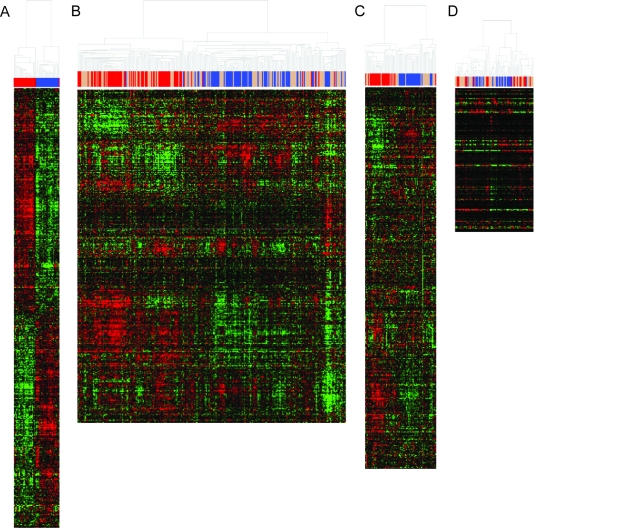
Heatmap of core serum response genes in each of the four data sets considered. Red are serum induced samples, blue are serum independent samples, and tan are unclassified samples. (A) Expression of 484 Unigene mapped core serum response genes in the 50 in vitro samples of the primary experiment (Chang et al. 2004). (B) Expression of the 376 core serum response genes in the 295 prostate tumor samples (Glinsky et al. 2004) (C) Expression of the 421 core serum response genes in the 78 van’t Veer samples (van’t Veer et al. 2002) (D) Expression of the 158 core serum response genes in the 86 Beer samples (Beer et al. 2002).